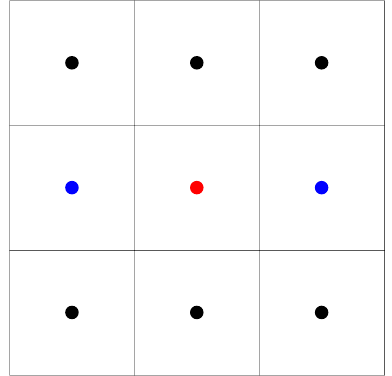
Figure 7 . The estimation of the terms in (5.9) and (5.10) requires us to divide the ( h; (cid:22) h ) plane into 9 regions. In the (cid:12)gure, the horizontal lines are h 0 = 0 ; h (cid:0) h 3 = 8 ; h + h 3 = 8 ; 1 while the vertical lines are (cid:22) h 0 = 0 ; (cid:22) h (cid:0) (cid:22) h 3 = 8 ; (cid:22) h + (cid:22) h 3 = 8 ; 1 . The di(cid:11)erent colors denote the di(cid:11)erent methods of treating them. As we will see, the region with red dot requires us to further subdivide it. We remark that the corner black ones can be colored blue as well, nonetheless in the main text, we have done the estimation in the \blue"